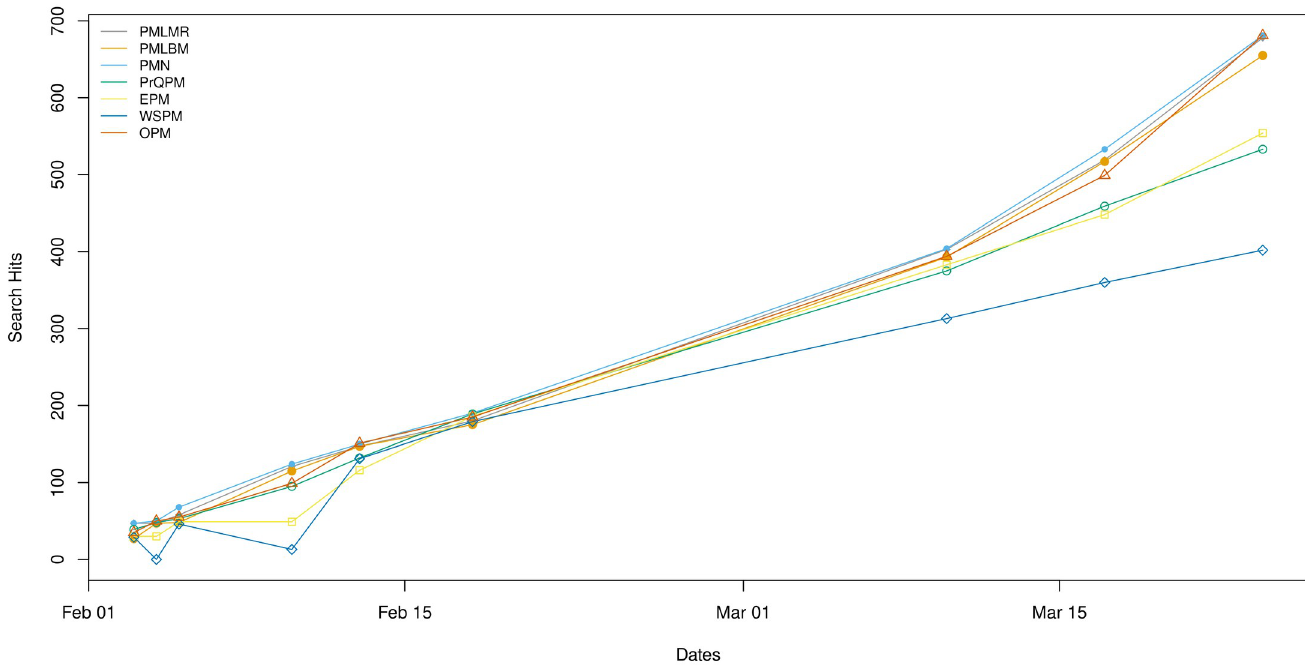
Fig 9. Search result count differences for COVID-19 related searches across PubMed based platforms. PubMed Legacy Most Recent Sort (PMLMR), PubMed Legacy Best Match Sort (PMLBM), PubMed New (PMN), ProQuest PubMed (PrQPM), EBSCOhost PubMed (EPM), Web of Science PubMed (WSPM), Ovid PubMed